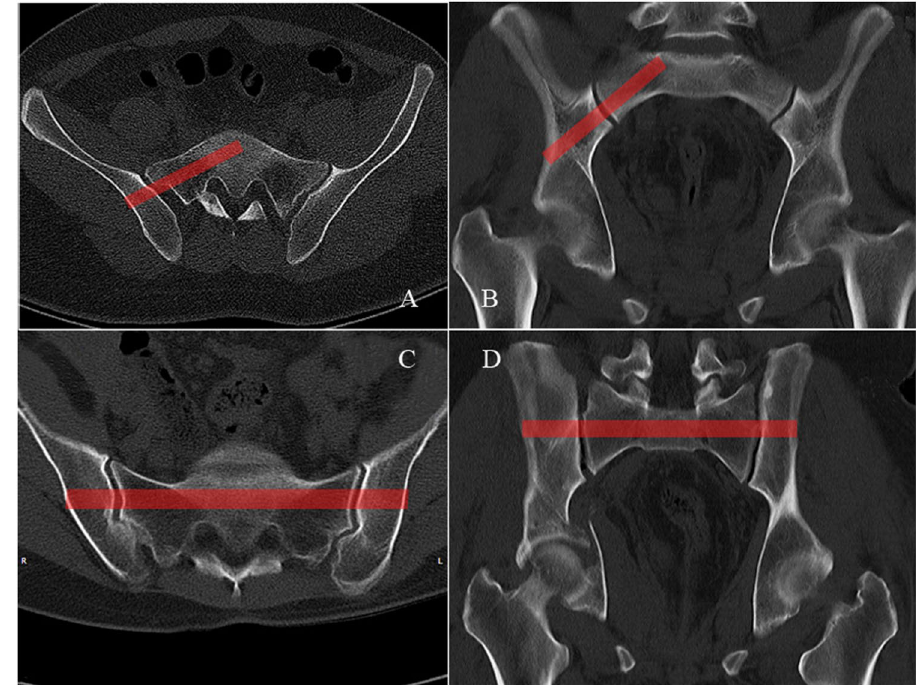
Figure 2. ( A,B ) The top sacral segment axial CT imagery of a patient with sacral dysmorphism. The dysmorphic sacrum has an oblique osseous pathway, which only allows oblique screw placement. ( C,D ) The top sacral segment axial CT imagery of a patient with a normal sacrum. The red column represents the pathway available for transverse screw placement.